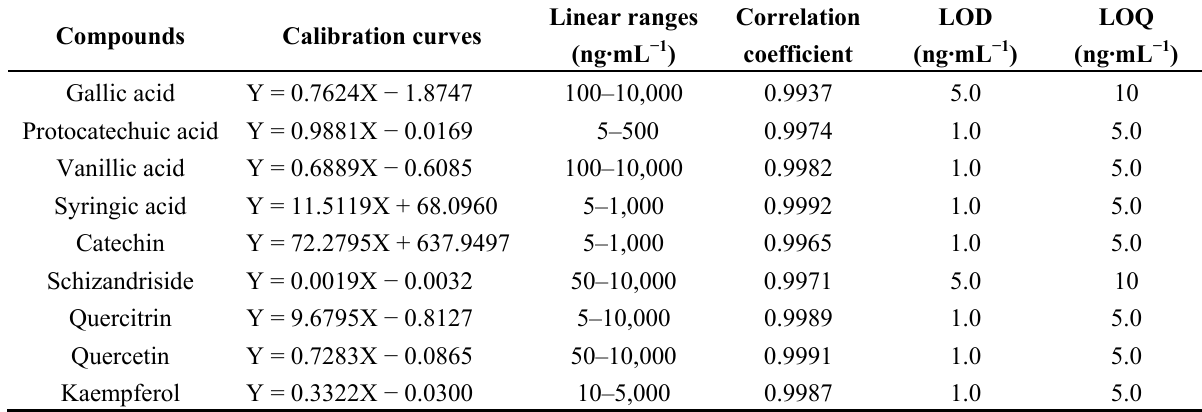
Table 2. Calibration curves, linear ranges, LOD and LOQ of the 9